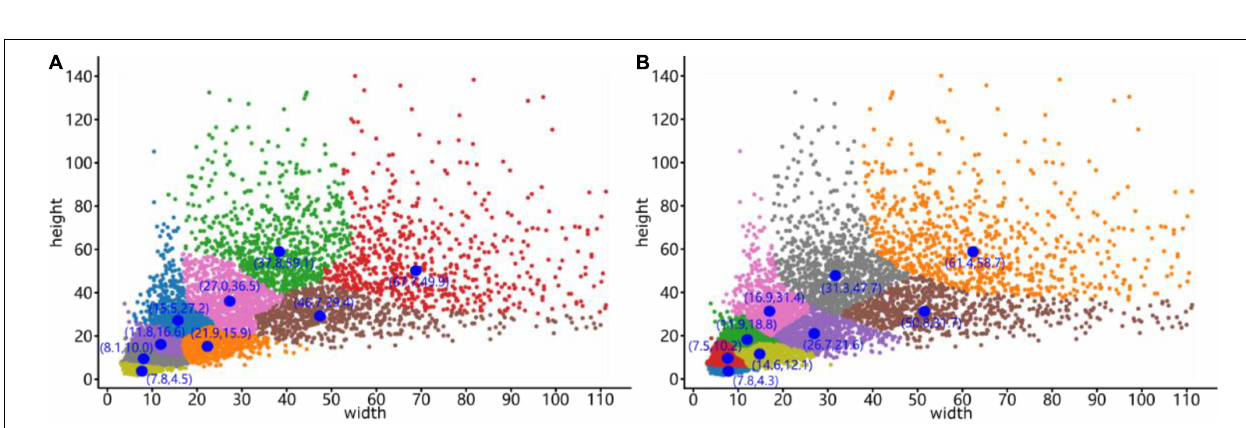
Frontiers in Plant Science |